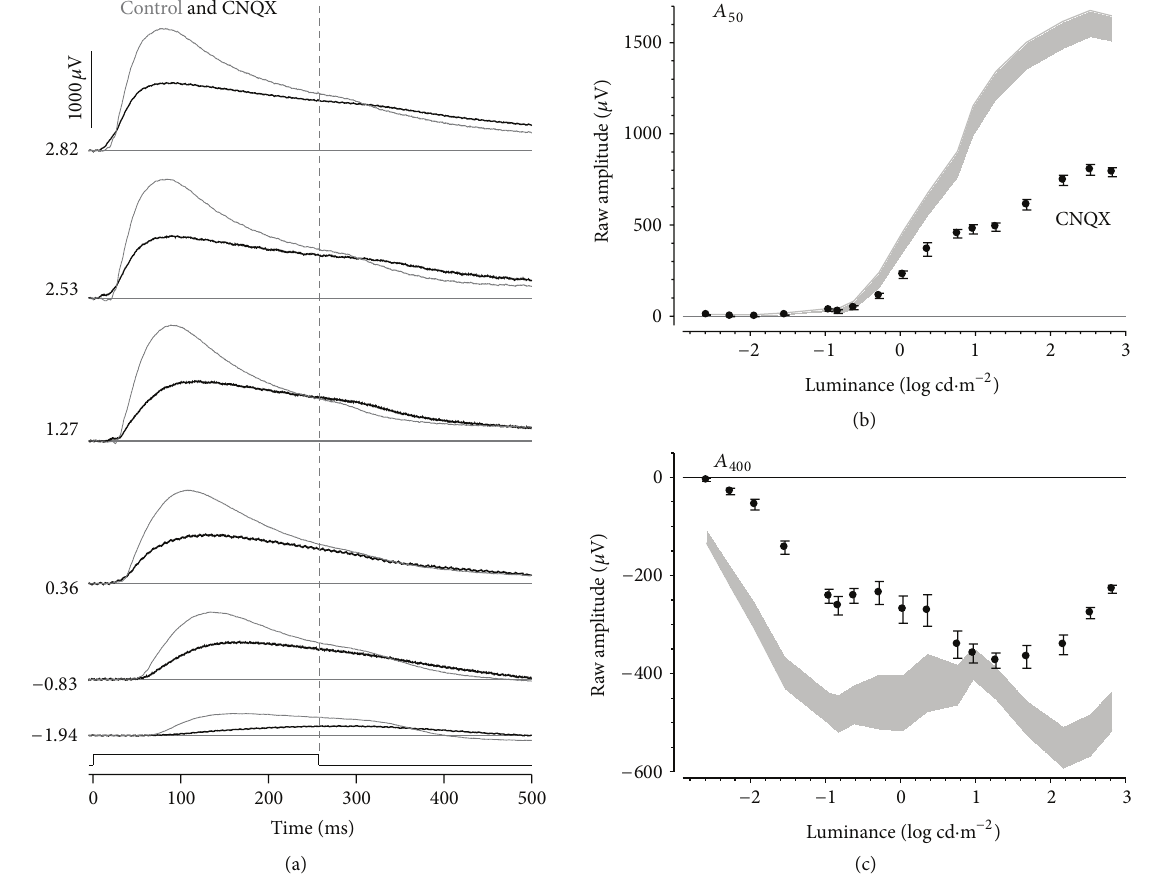
Figure 2: Effect of CNQX on rat-isolated PII. (a) Representative CNQX waveforms (thick) compared to its fellow control eye (thin). Lumi- nance is given in logcd ⋅ m −2 along the left. Grouped average ( ± SEM) amplitudes at fixed times of 50 (b) and 400ms (c) are plotted against luminance. CNQX-treated (black filled) data are compared against control eyes (grey areas indicate 95% confidence intervals of controls as calculated from the